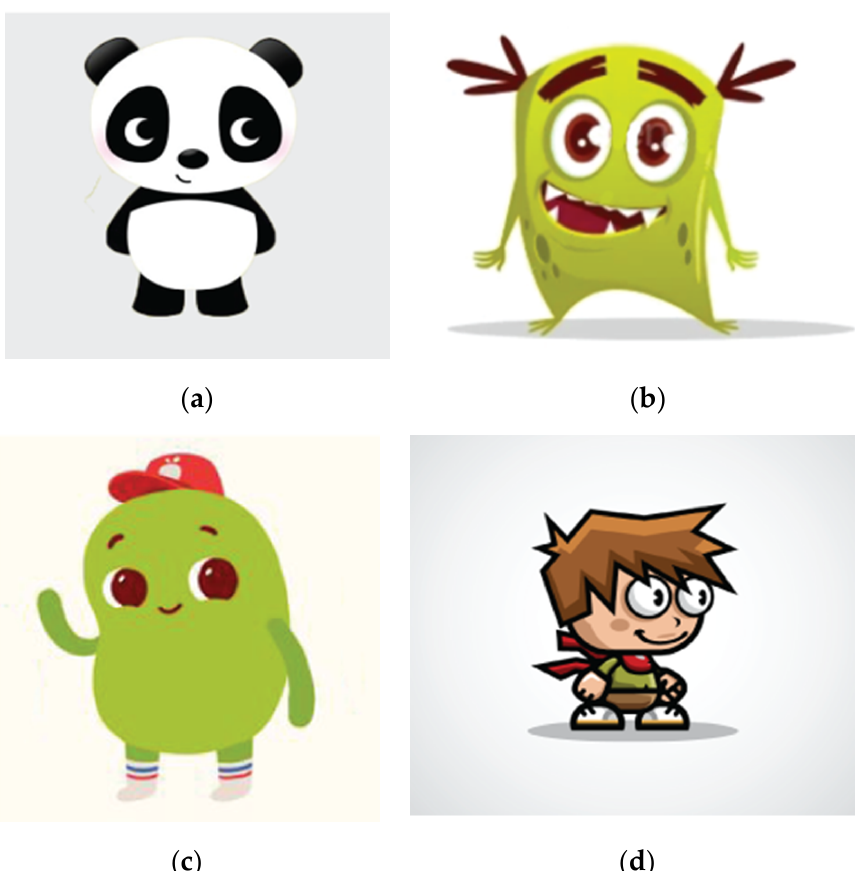
Figure 8. Characters proposed to the parents, from which they had to select the most attractive for their children: ( a ) the tender animal, ( b ) the little monster, ( c ) the little bean, and ( d ) the little boy. Subsequently, parents had to select, among different game controllers (Figure 9), the most intriguing, the most enjoyable, and the one that their child would use the most. Preferences were overlapping and similar, as shown in Table 5, which reports the five most selected devices for each of the three categories (i.e., the most intriguing, en- joyable, and used). In addition, parents’ answers in Table 5 reveal that families showed a tendency to choose items they were familiar with (e.g., the steering wheel, button, etc.), while excluding the less common/known solutions. Table 5. Five most selected controllers for each of the three categories (i.e., the most intriguing, enjoyable and used), as reported by parents.